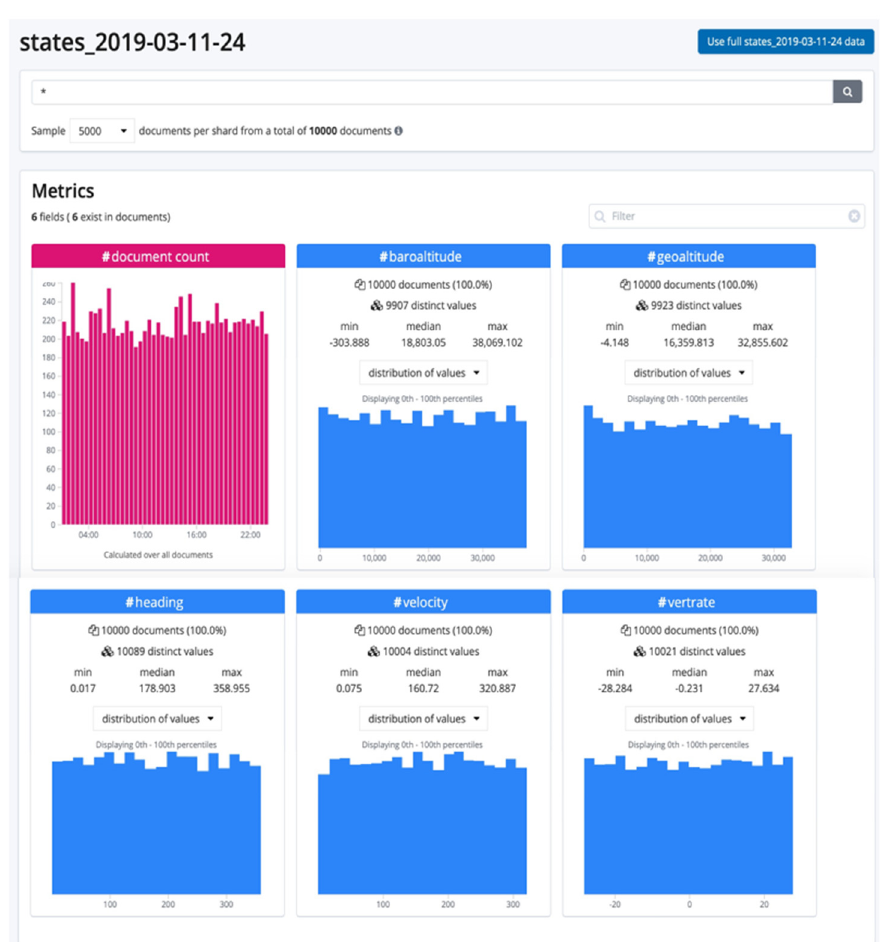
Figure 5. Elastic Kabana Visualizations of Statistics of Generated ADS-B Network Attacks.